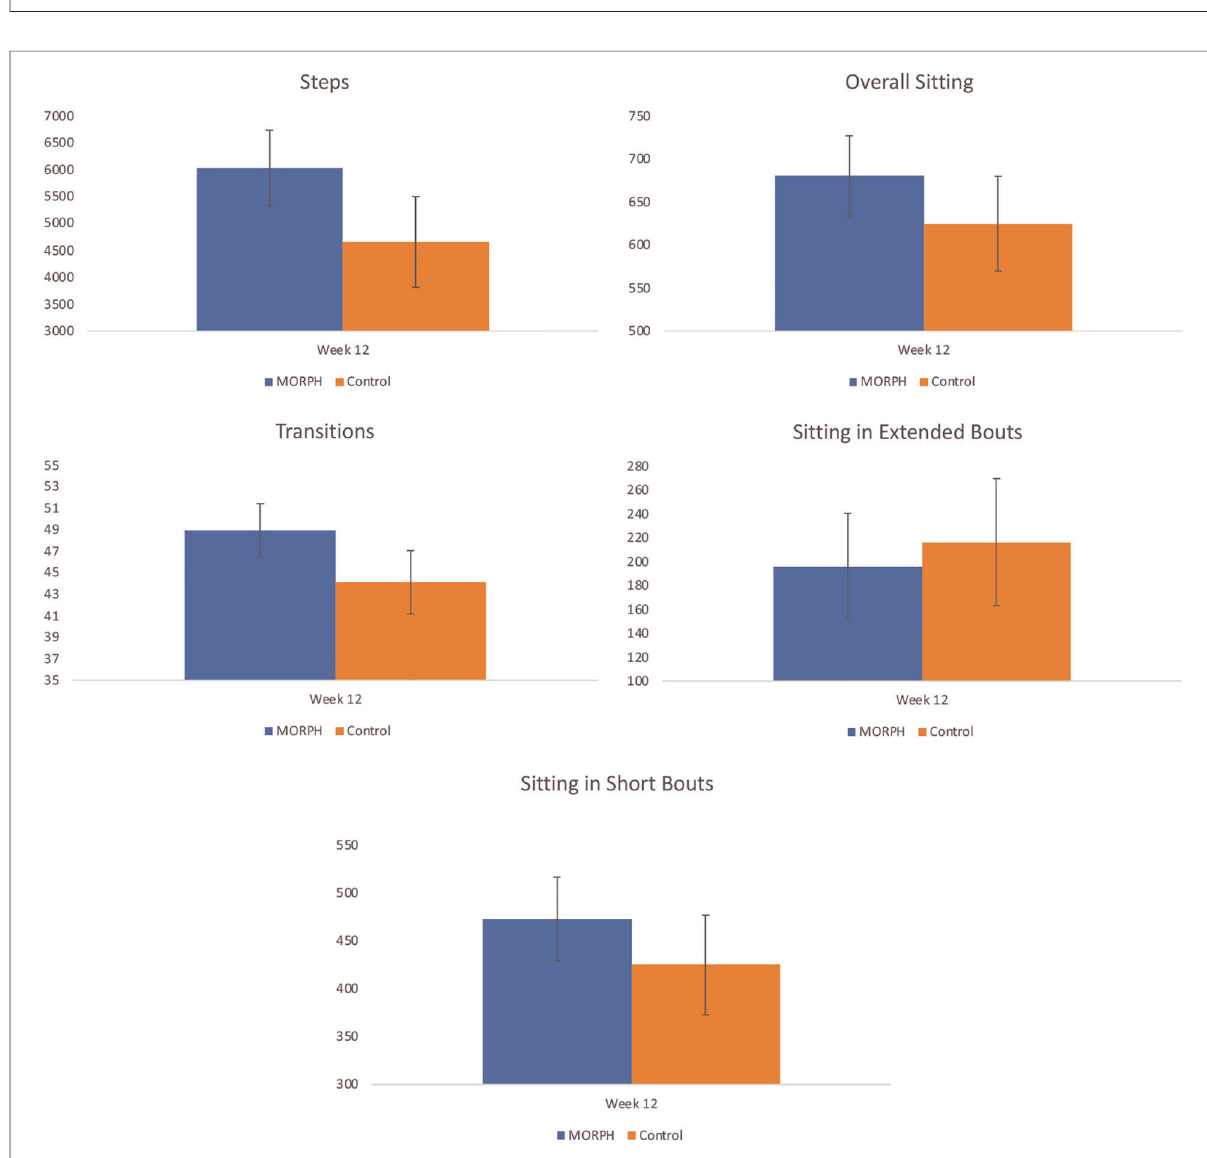
FIGURE 6 Baseline-adjusted markers of physical activity and sedentary behavior collected via ActivPAL at week 12.